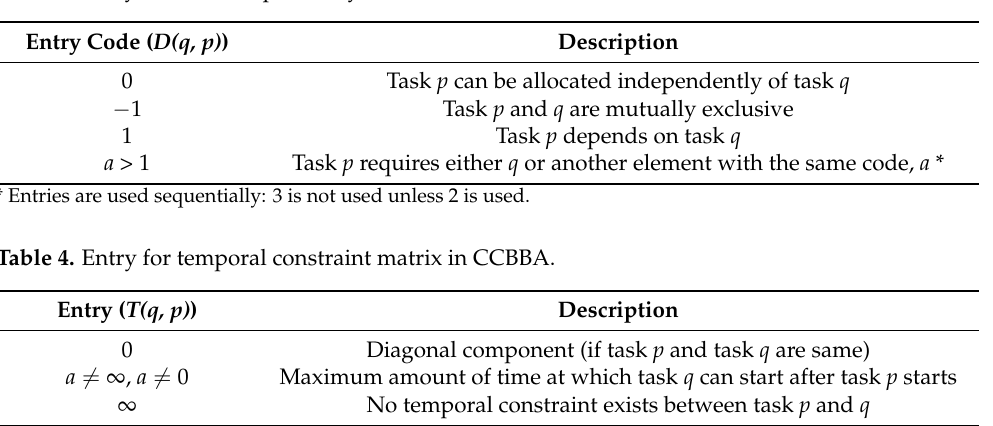
Table 3. Entry codes for dependency matrix in CCBBA.